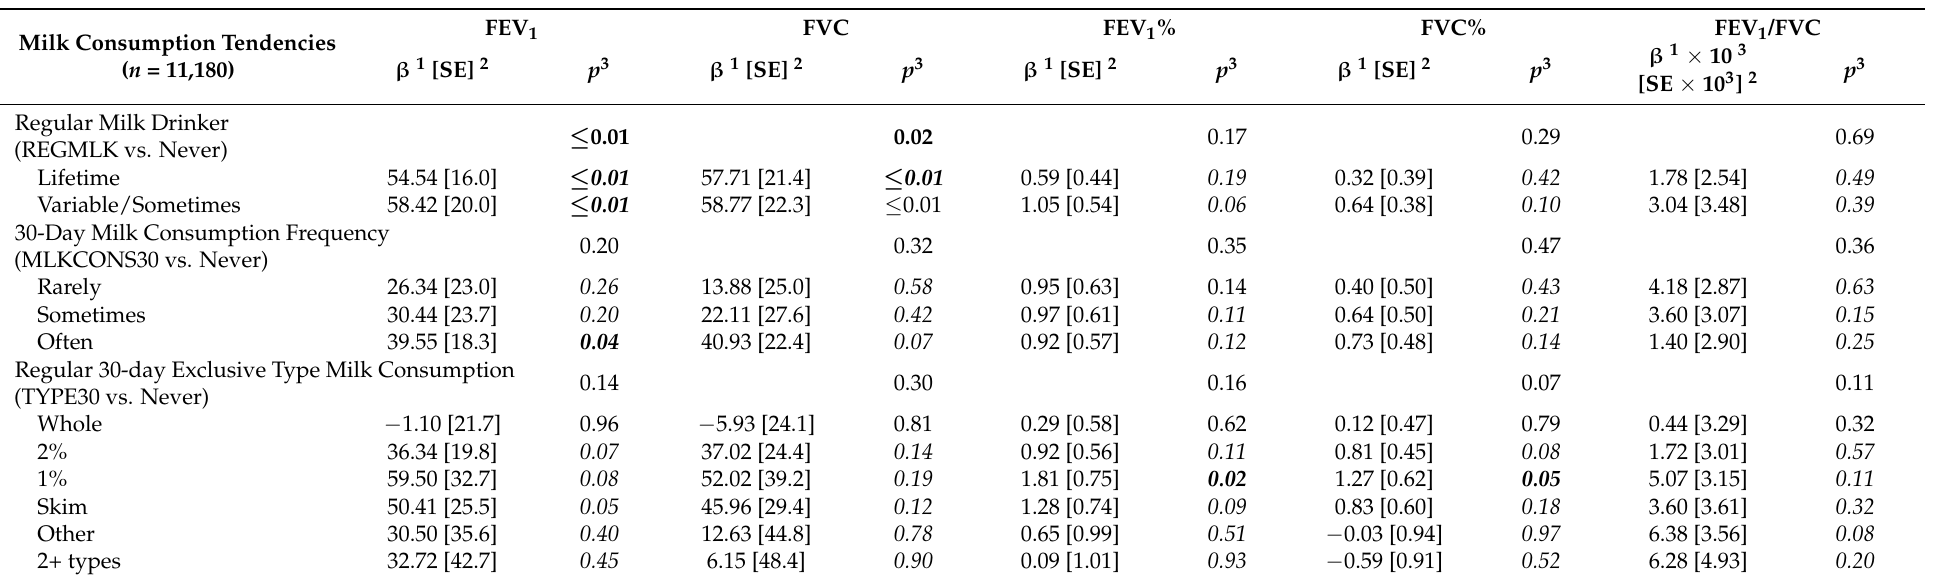
Table 3. Multivariable models of associations between milk consumption tendencies and lung function measurements in the total NHANES